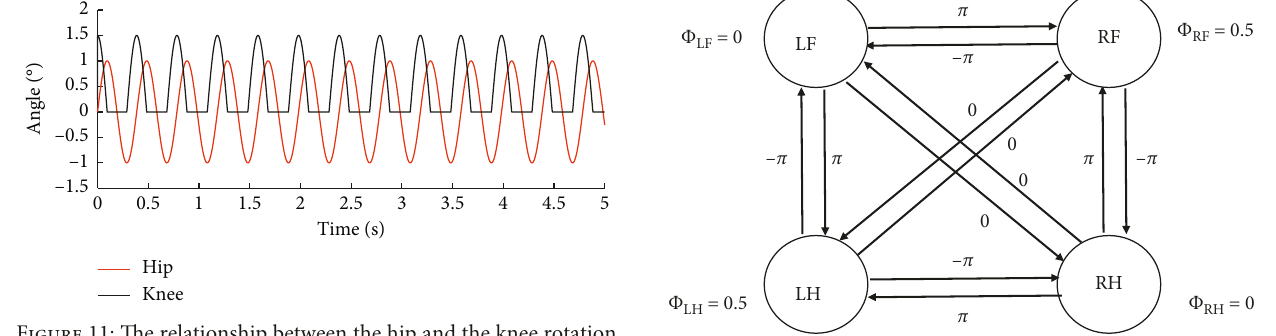
Figure 15: Relative phase relation of the trot